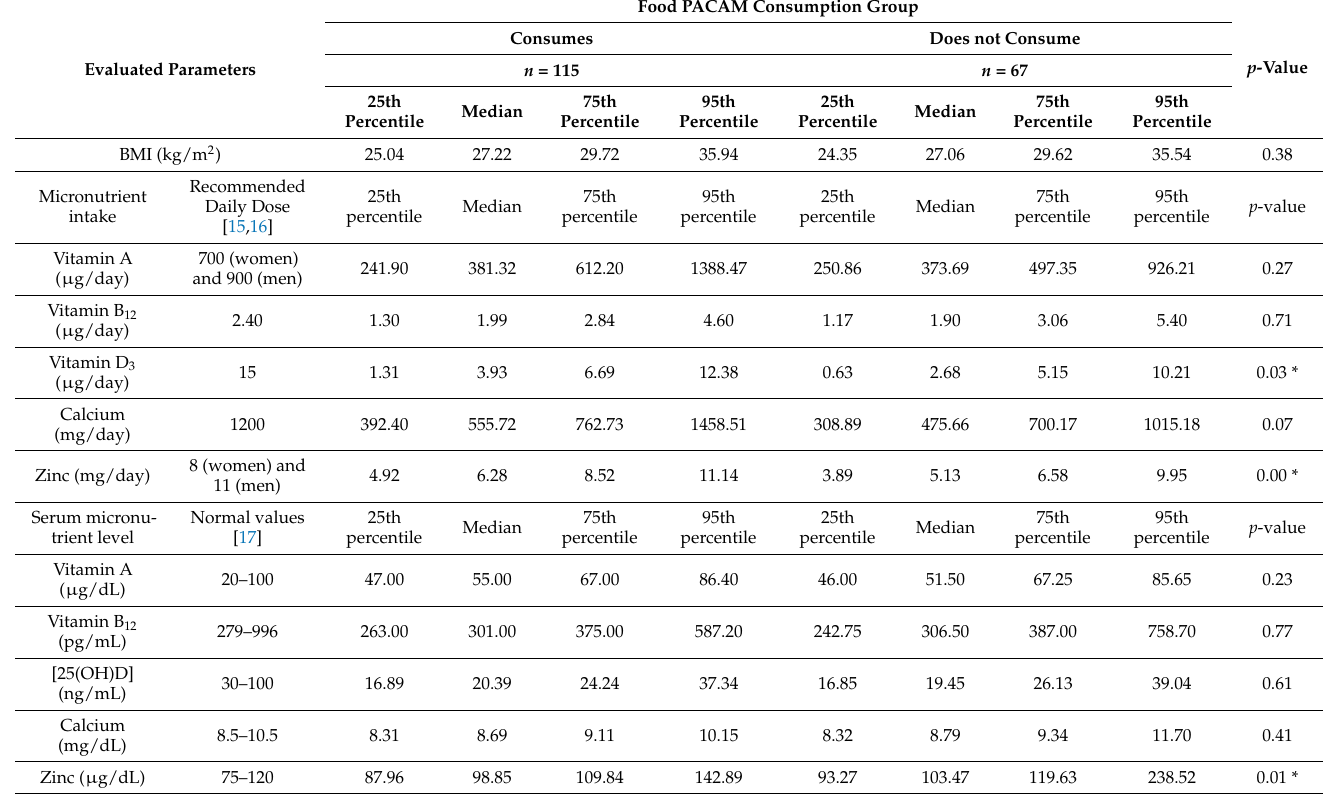
Table 4. Influence of the PACAM foods consumption on the BMI, micronutrient intake and serum micronutrient levels of elderly from Metropolitan Region, Santiago,